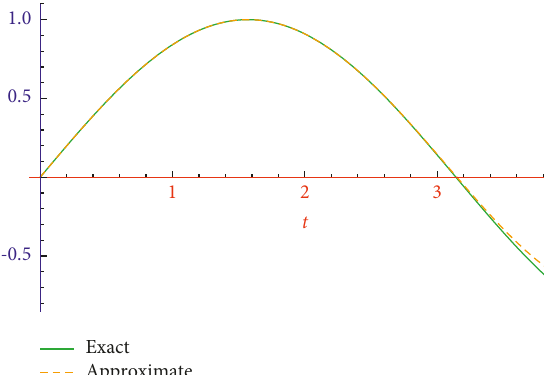
Figure 1: 2D Plot for ϑ ( t ) with various parameters of α .